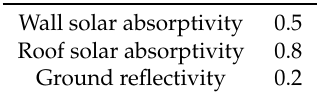
Table A5. Roof and wall solar heating parameters.